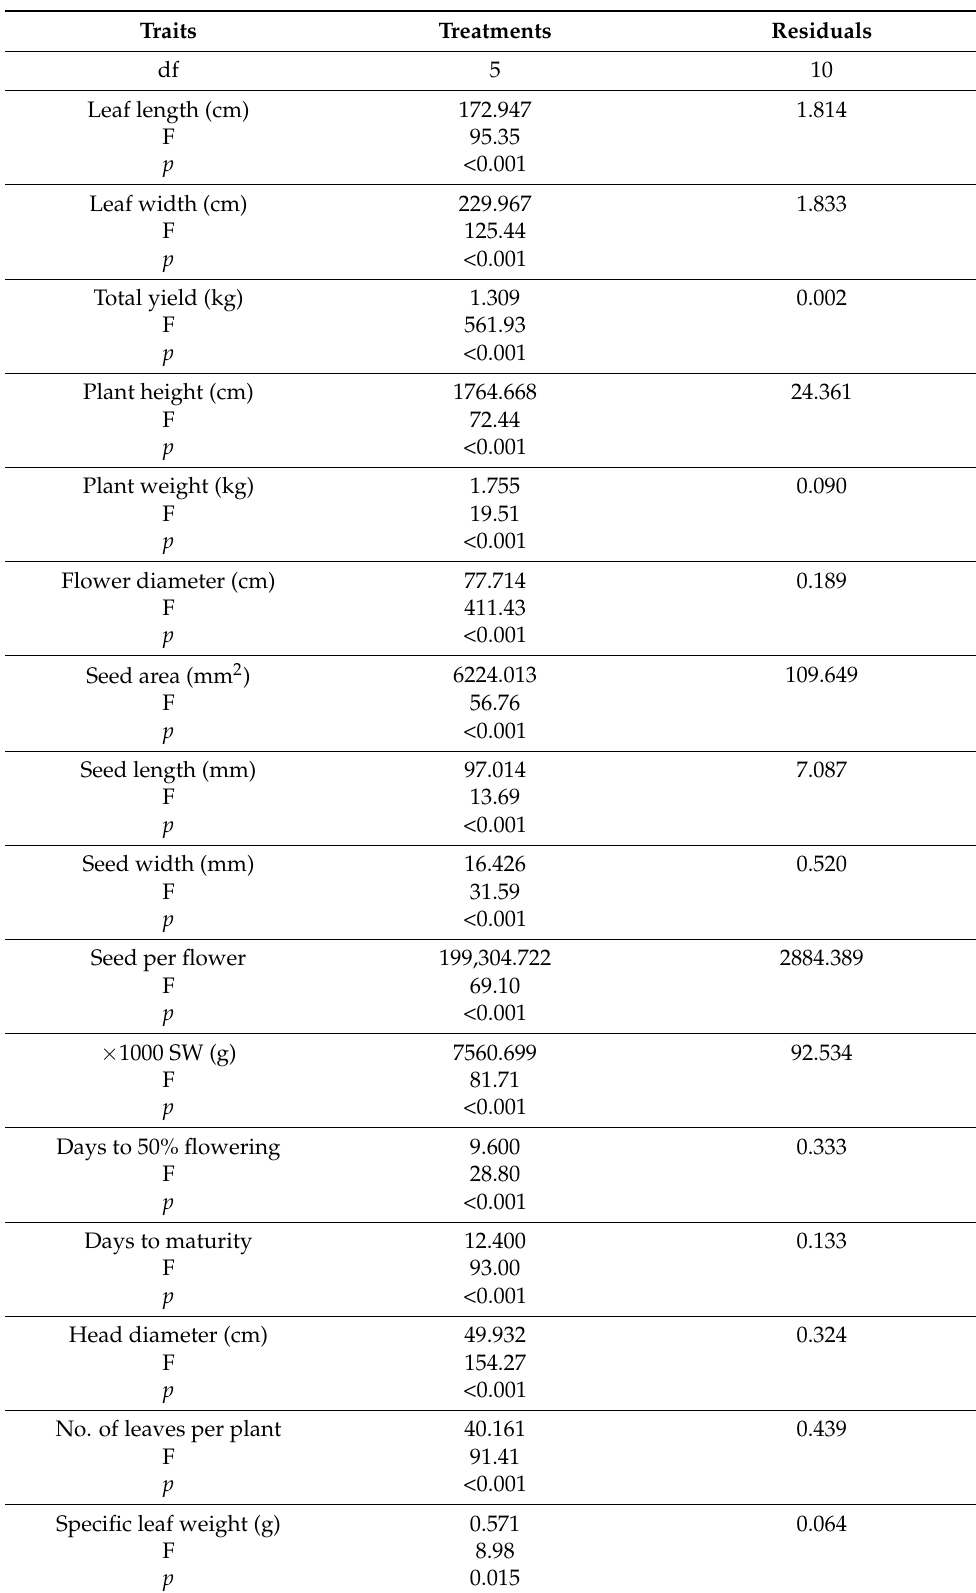
Table 1. Variance analysis of the effects of different treatments on the morphological and biochemical traits of